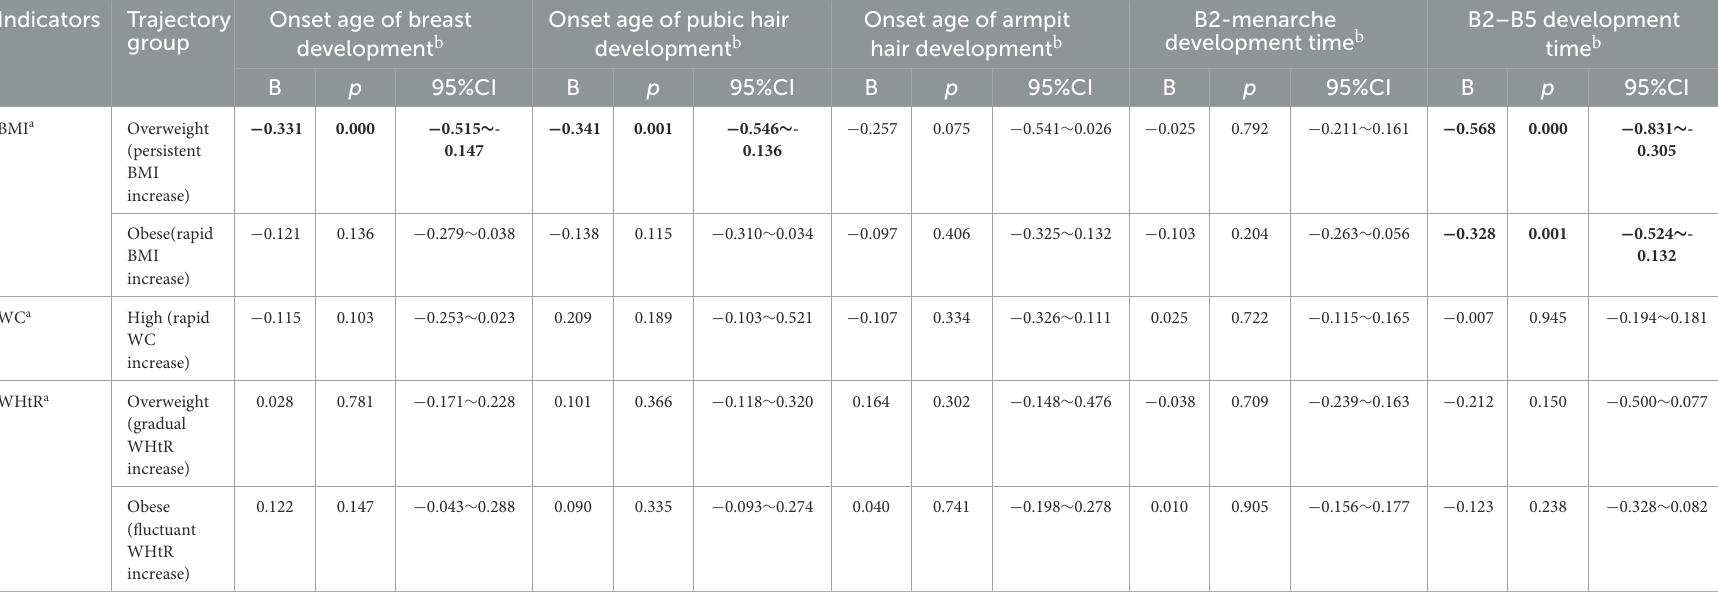
TABLE 4 The relationship between the trajectory of obesity indicators and the different onset ages of puberty and pubertal tempo before pubertal